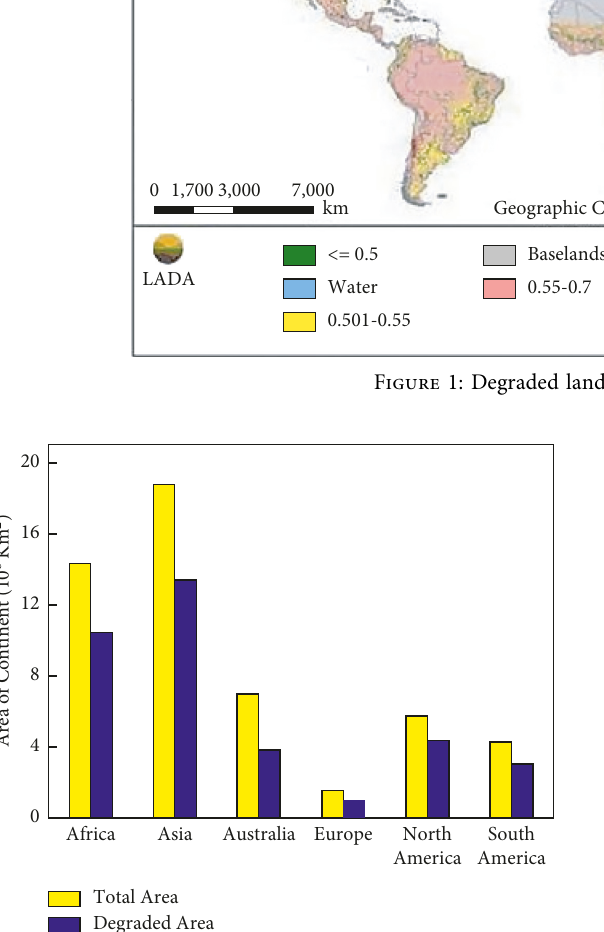
Figure 2: A holistic estimate of distressed and exploited land in dry